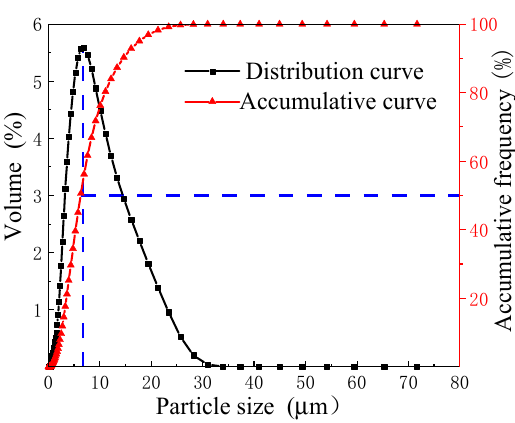
Figure 1. X-ray diffraction patterns of pyrite.